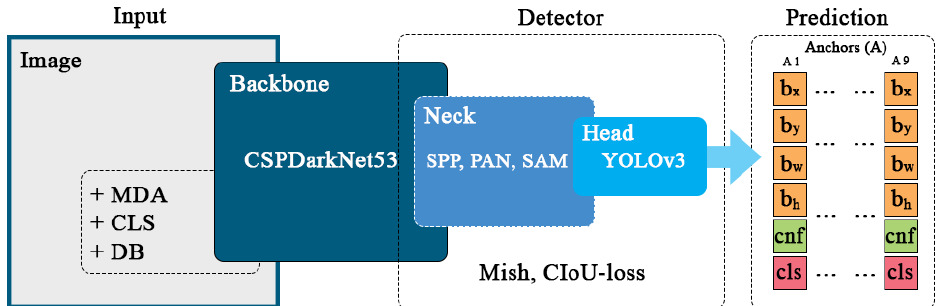
Figure 6. The network structure of the proposed three-level human detection module.